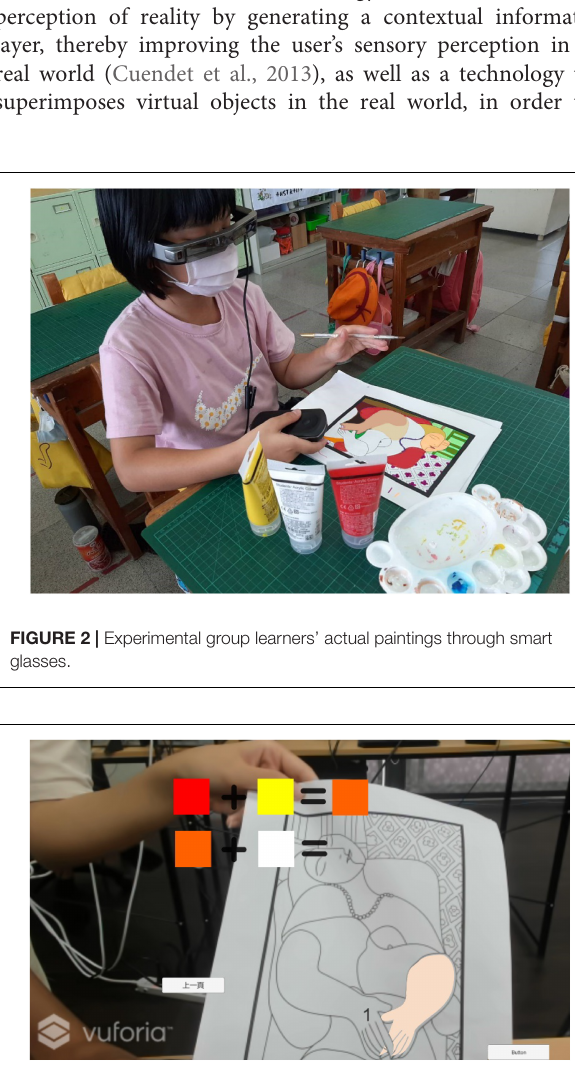
FIGURE 3 | Using AI to assist and guide learners to learn about color recognition and draw at the same time.